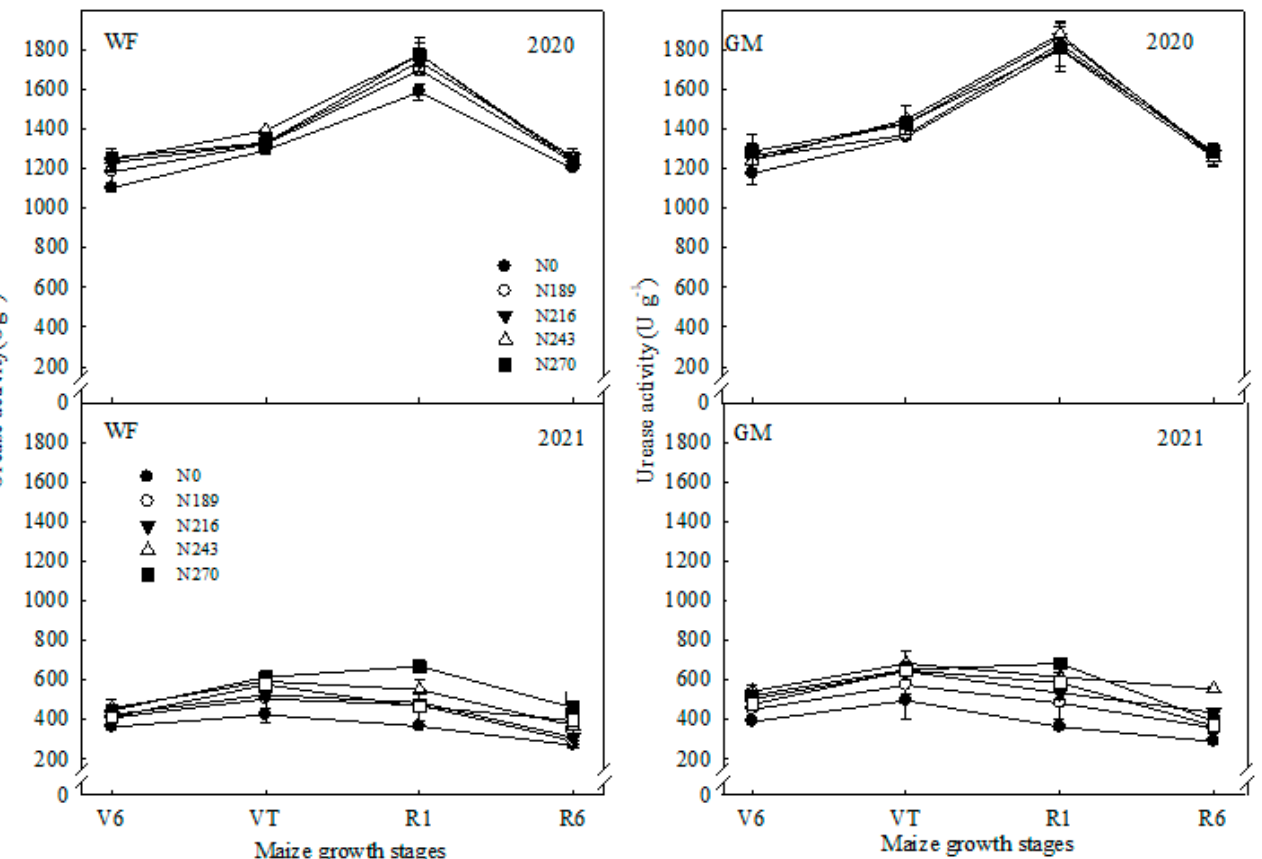
Figure 4. The soil urease activity response to N application under WF and GM treatments in the North China Plain. V6, spring maize jointing stage; VT, spring maize tasseling stage; R1, spring maize filling stage; R6, spring maize maturity stage.